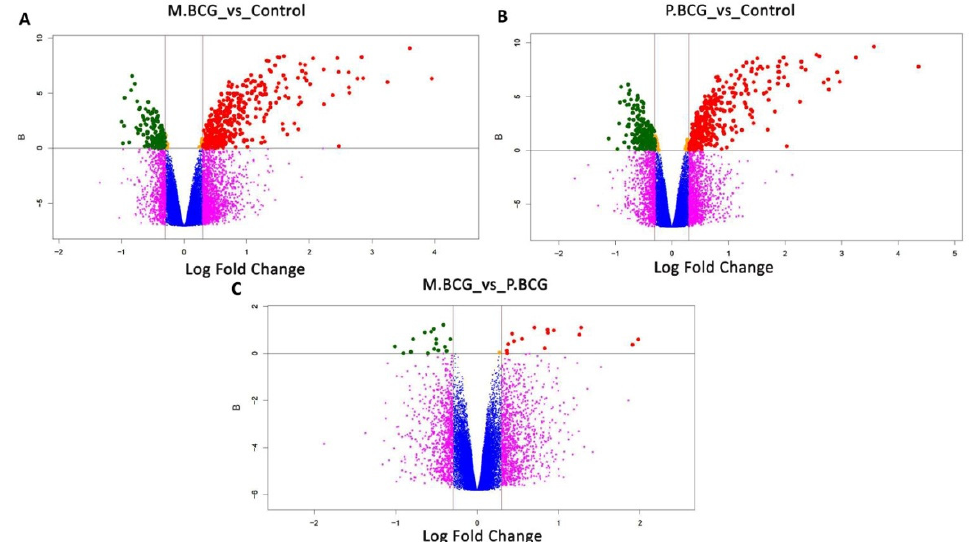
Figure 2. Volcano plot displaying differentially expressed genes in THP-1-derived macrophages: ( A ) Mexico BCG strain vs. control; ( B ) Phipps BCG strain vs. control; ( C ) Mexico BCG strain vs. Phipps BCG strain. B-statistic values are plotted against the log fold change (base 2). A B-statistic of zero corresponds to a 50–50 chance that the gene is differentially expressed (gray line). On the x axis, values outside the red lines represent log fold changes of ≥ 0.3 between M.BCG and P.BCG. Red and green dots represent over- and subexpressed genes, respectively.